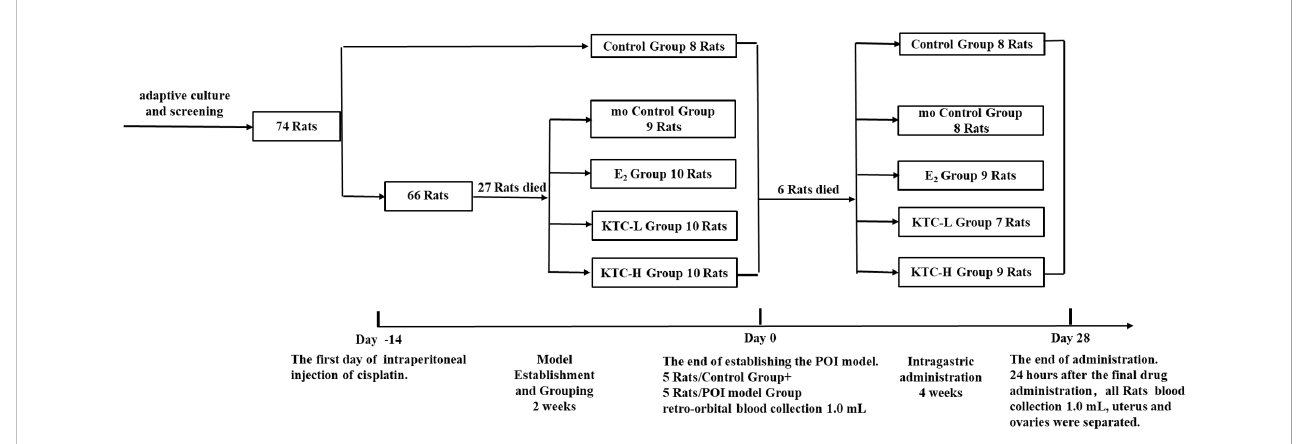
FIGURE 1 Flow chart of the